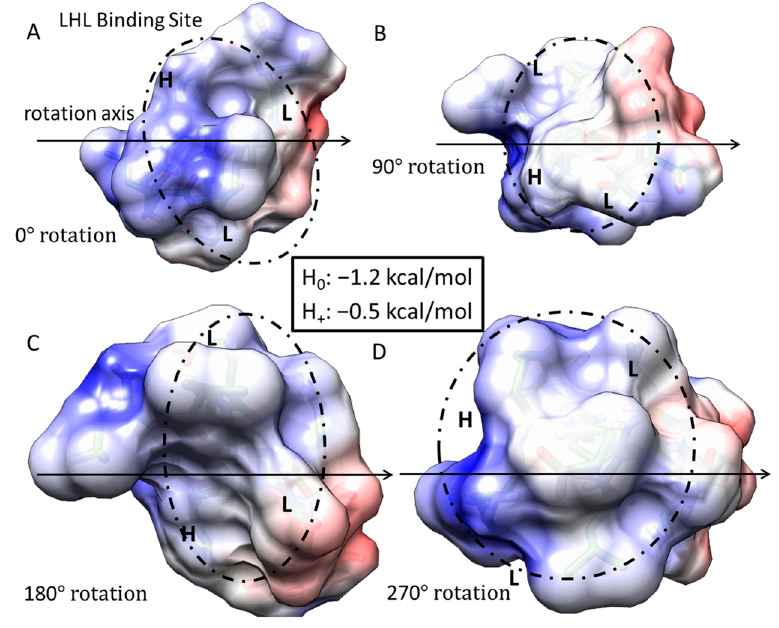
Figure 4. Free energy of binding estimates for sets of three adjacent residues for LRR-10 (LRELHLNNN) on human collagen type I alpha chain 2 (COL1A2) residues 861–871. The binding site (LHL) reference view is in ( A ), with views of 90° rotations along the indicated axis in ( B – D ). Each circle represents the same potential three-amino-acid binding site between the LRR-10 peptide and collagen at different rotations.